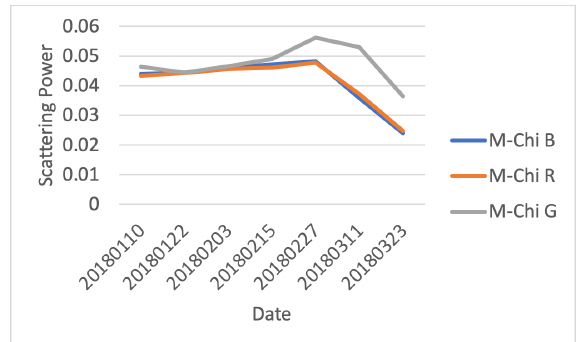
Figure 2. Time-series of the average scattering powers of all 58 fields for the three scattering components of the M-Chi decomposition including single-bounce (M-Chi B), double- bounce (M-Chi R) and volume scattering (M-Chi